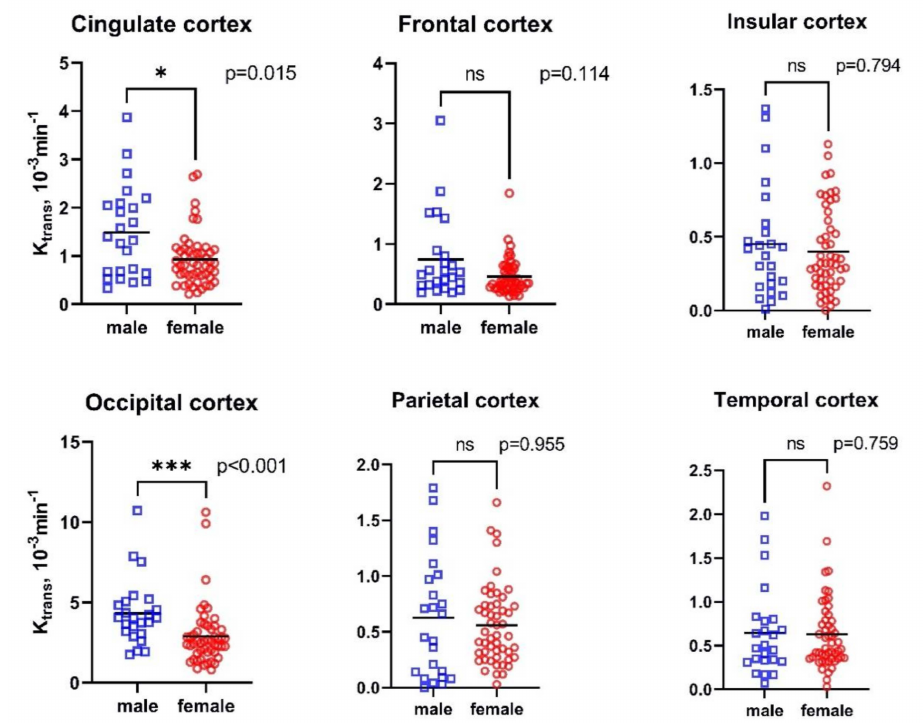
Figure 1. Differences in cerebral regional K trans according to sex. p , p -value; *, p -value < 0.05; ***, p -value <